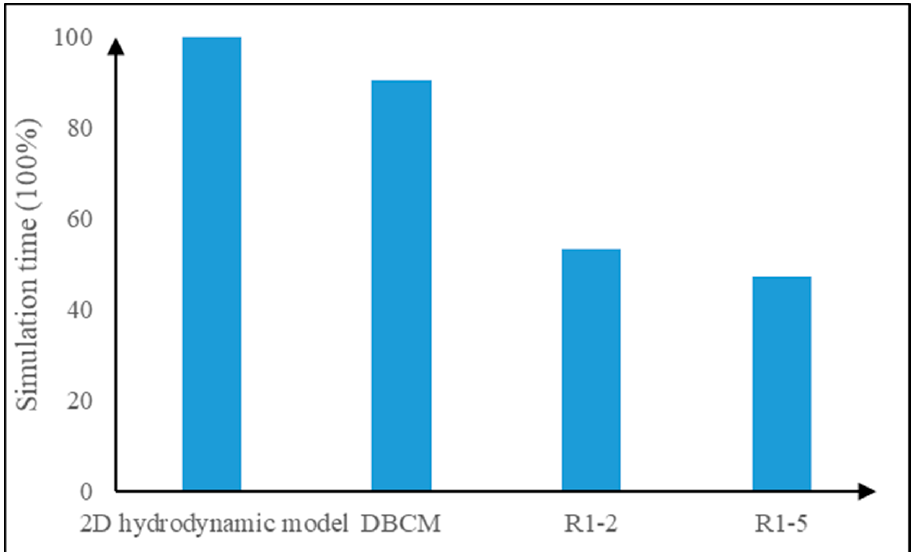
Figure 9. The simulation time of different models.